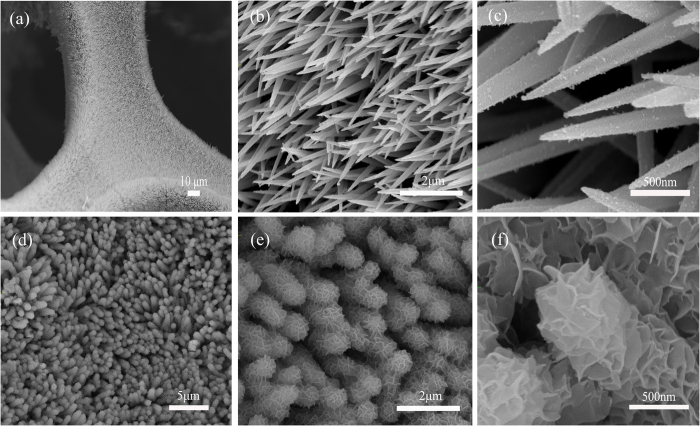
SEM images of NiCo2S4 NWAs (a,b and c) at different magnifications; SEM images of NiCo2S4@NiO NWAs (d,e, and f) at different magnifications.